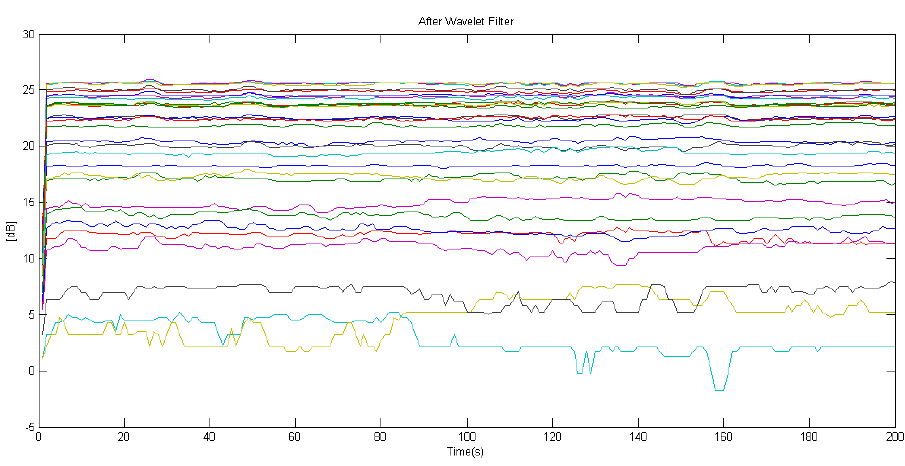
Figure 4. Filtered CFR for coughing.